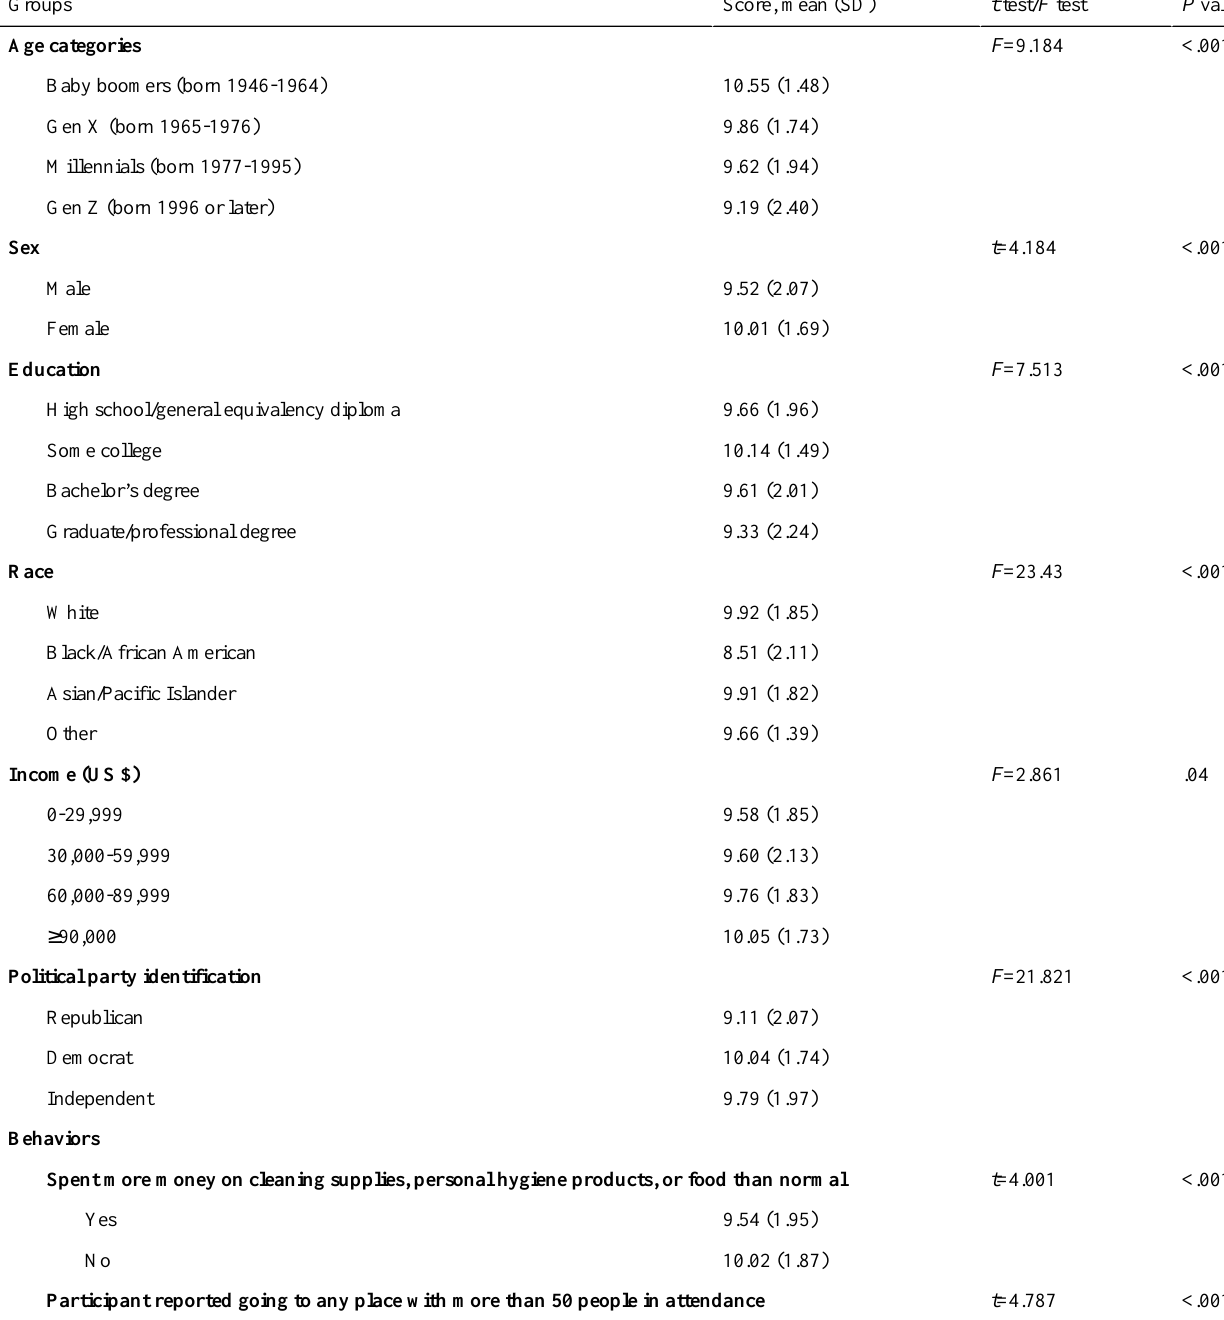
Table 2. Group comparisons of knowledge scores and age comparisons of participants